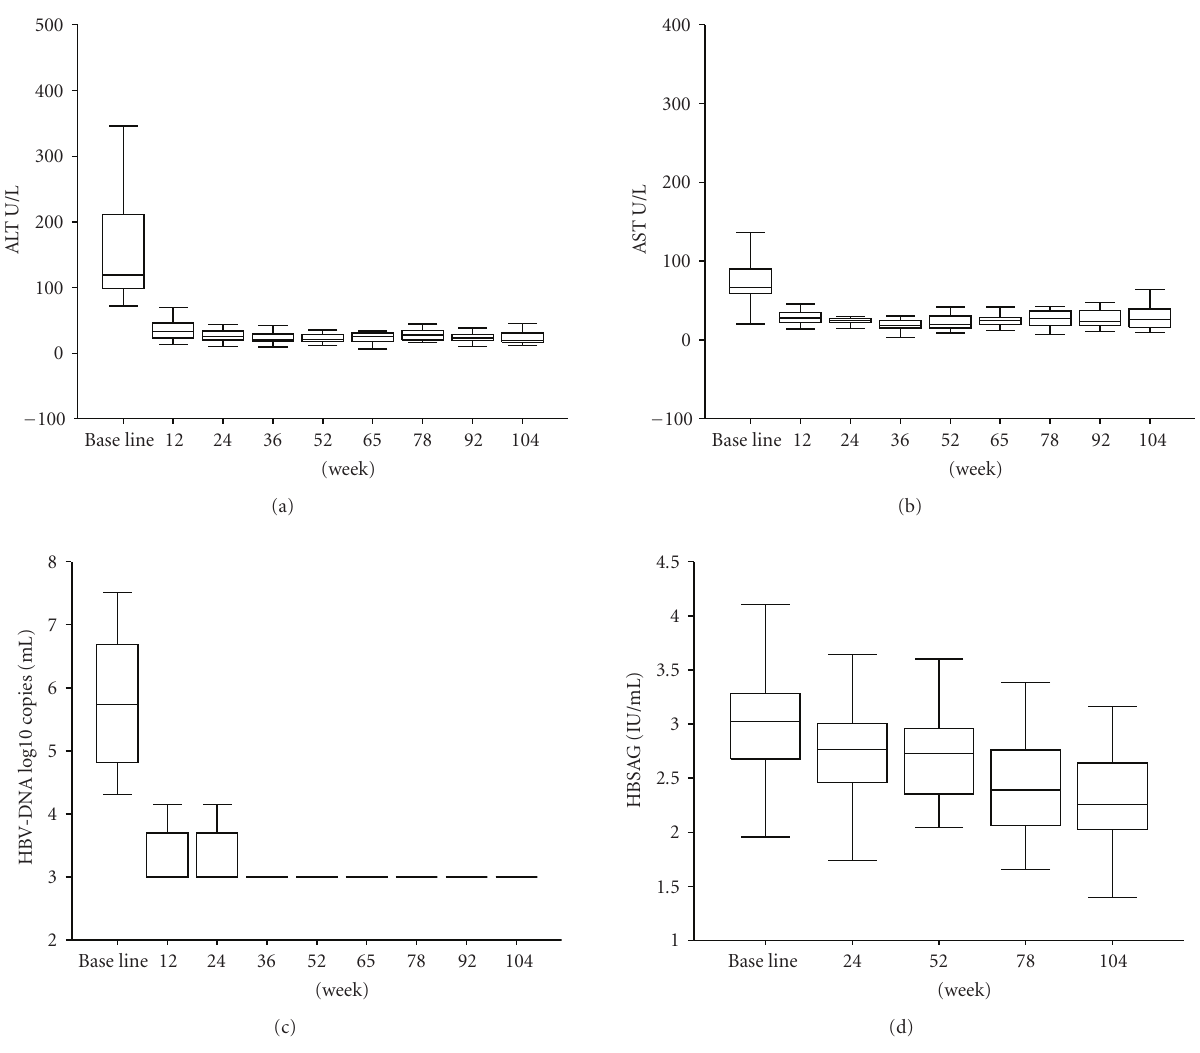
Figure 2: Biochemical and virological responses after adefovir dipivoxil treatment. ALT (a), AST (b), HBV-DNA loading (c), and HBsAg levels (d) were examined in the serum samples from chronic HBV patients at adefovir dipivoxil treatment week of 0 (baseline), 12, 24, 36, 52, 65, 78, 92, and 104 ( P value for all treatment were statistically di ff erent from baseline <